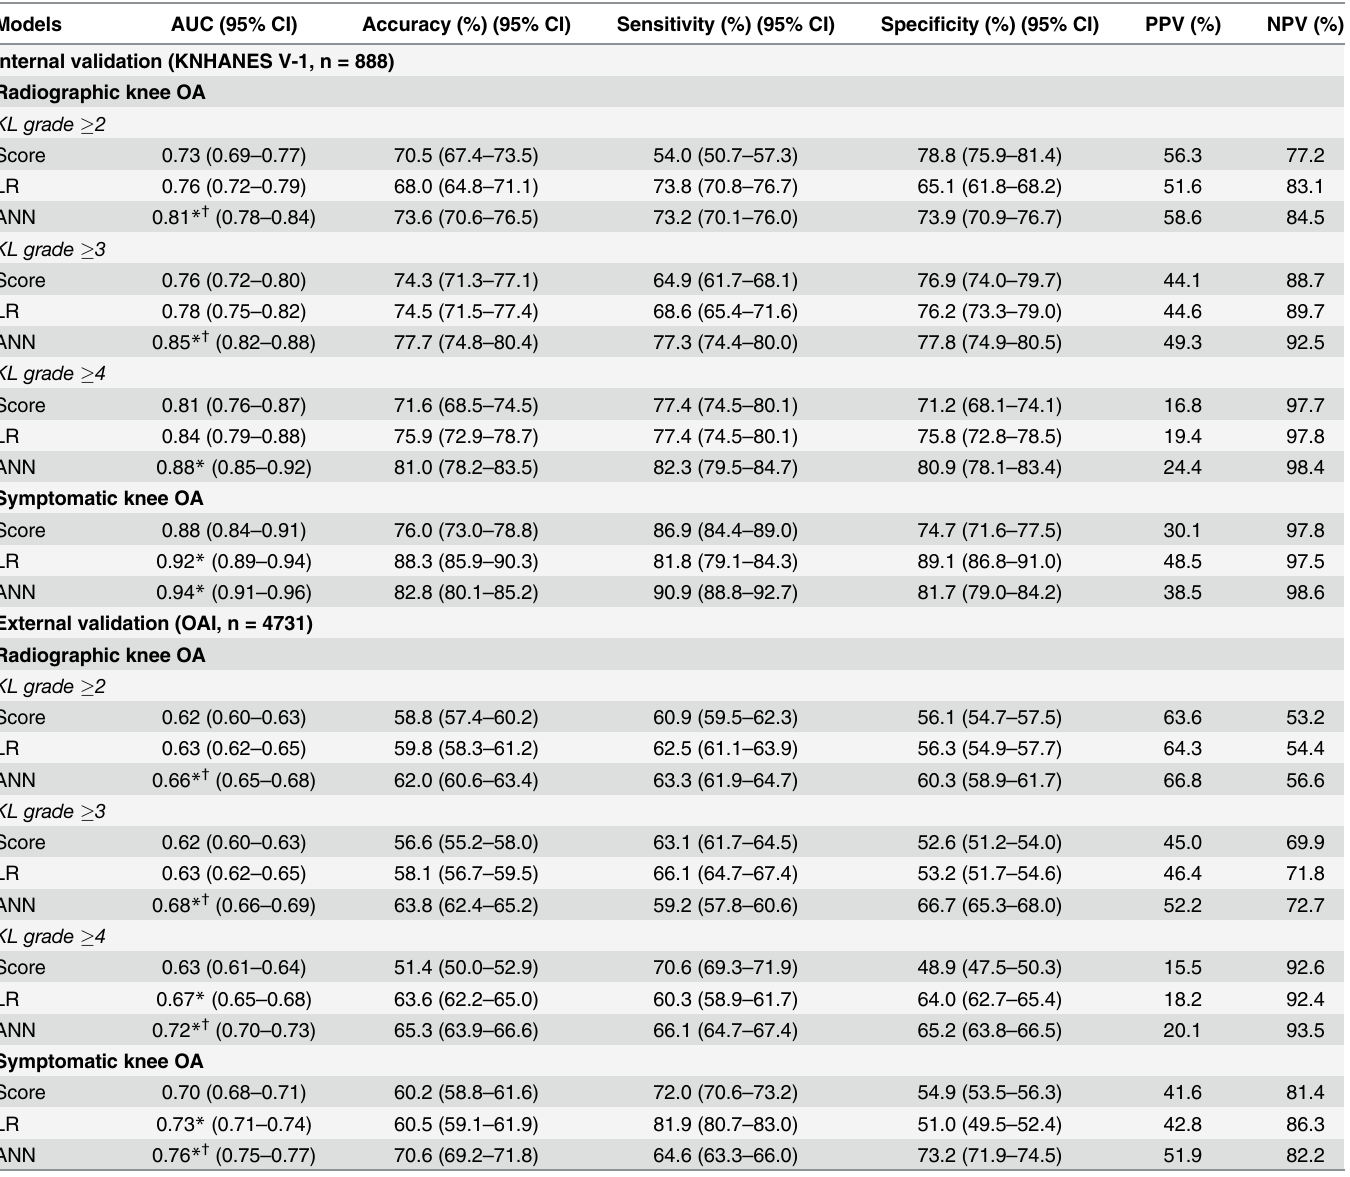
Table 3. Performance of prediction models on internal and external validation